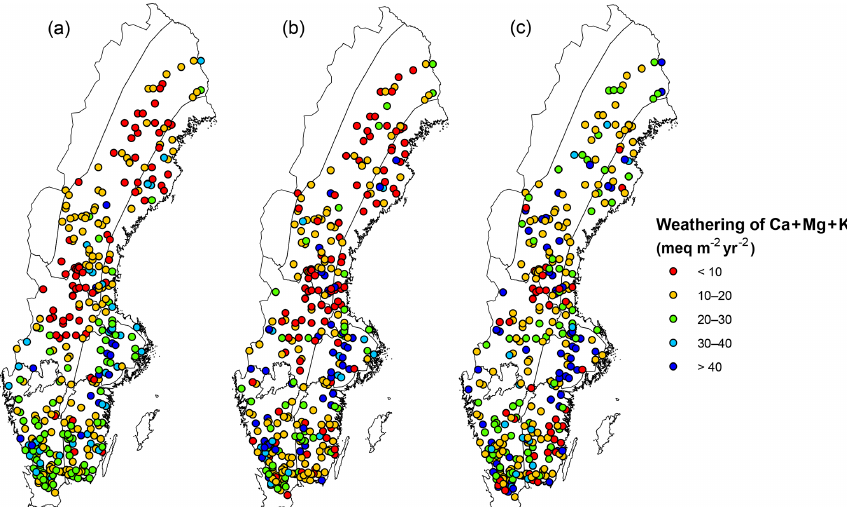
Figure 4. Weathering rates on a regional scale on 346 National Forest Inventory (NFI) sites, calculated with the depletion method/total analysis regression approach (a) , modelled with PROFILE (b) and with ForSAFE (c) , in seven climate regions in Sweden, delimited by black